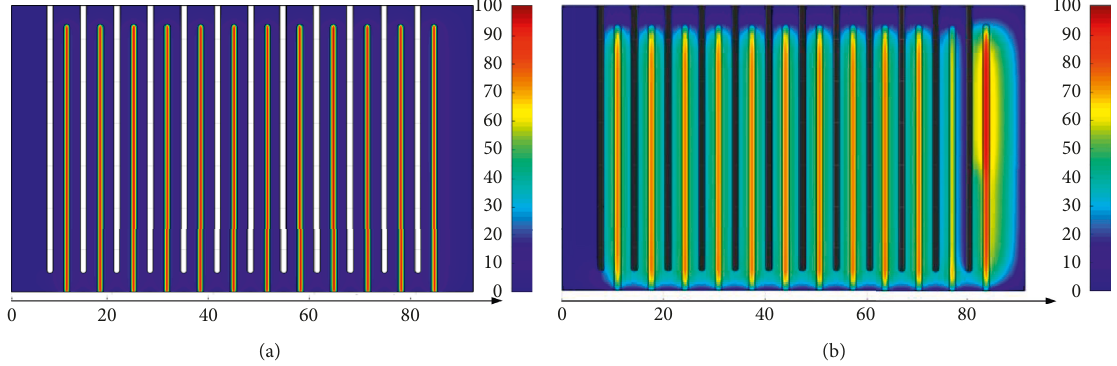
Figure 4: The distribution of the water temperature at the initial time (a) and after 240min